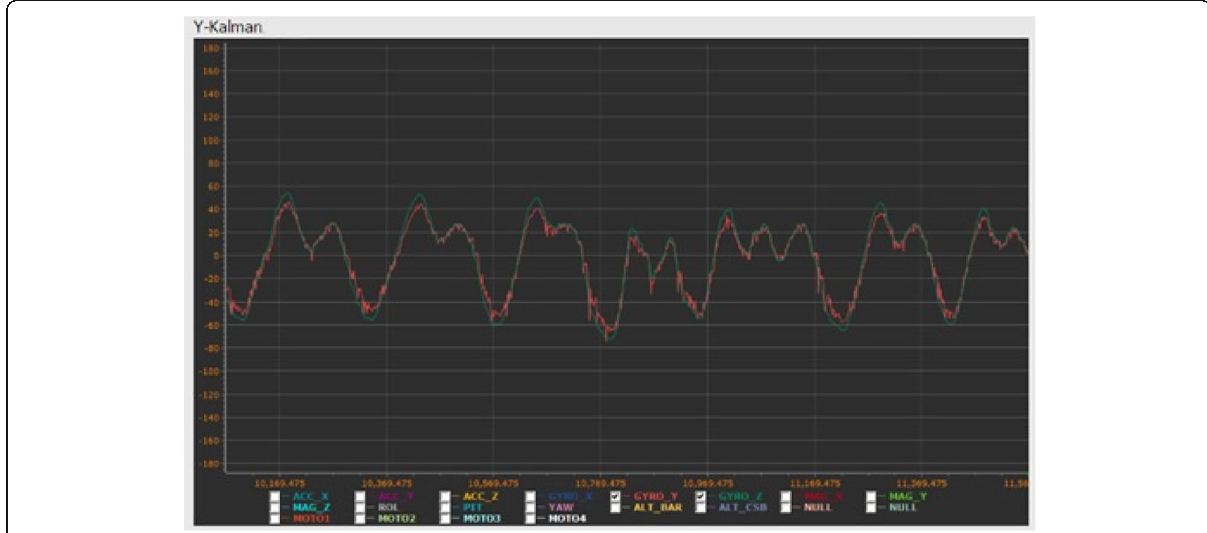
Fig. 39 Waveform comparison